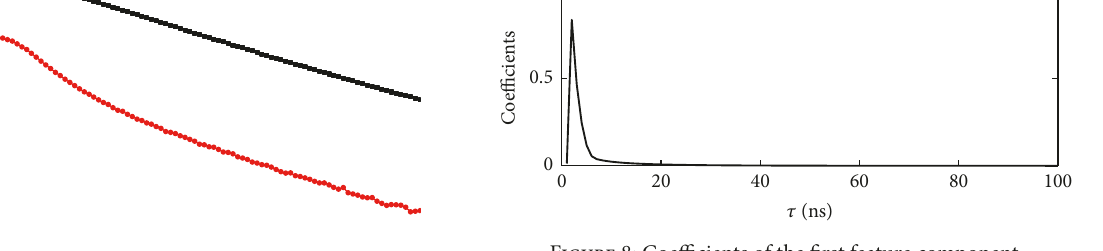
Figure 8: Coefficients of the first feature component.